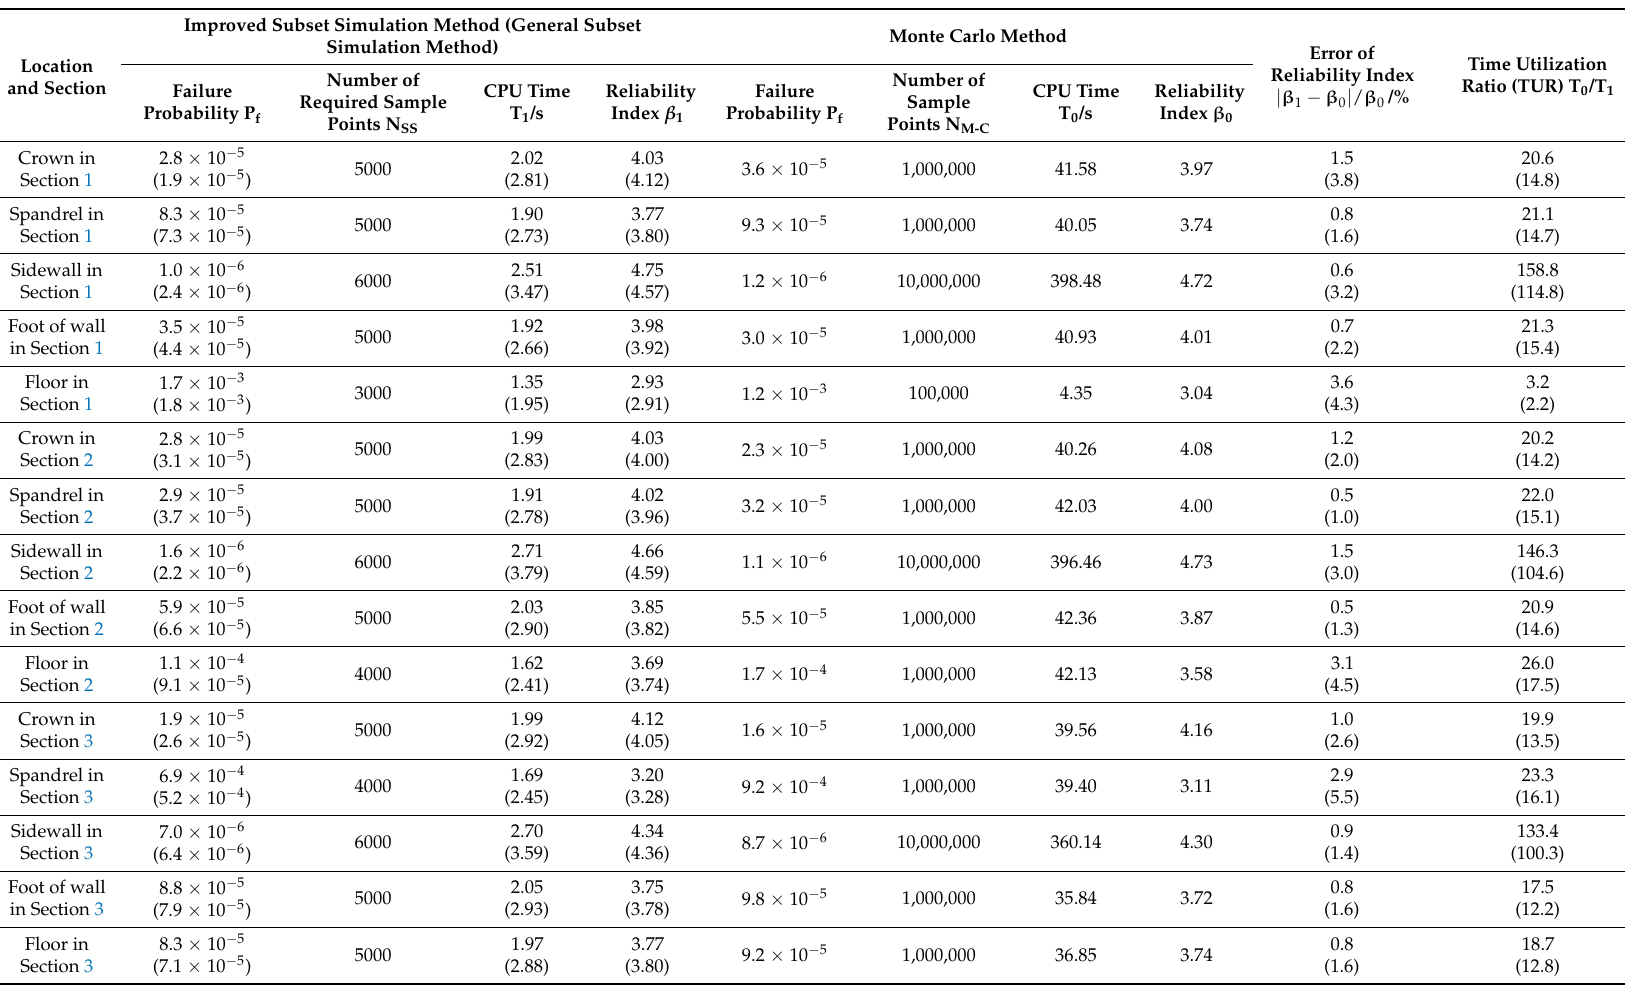
Table 6. Comparison of the failure probability among the traditional Monte Carlo, the subset simulation and its improved